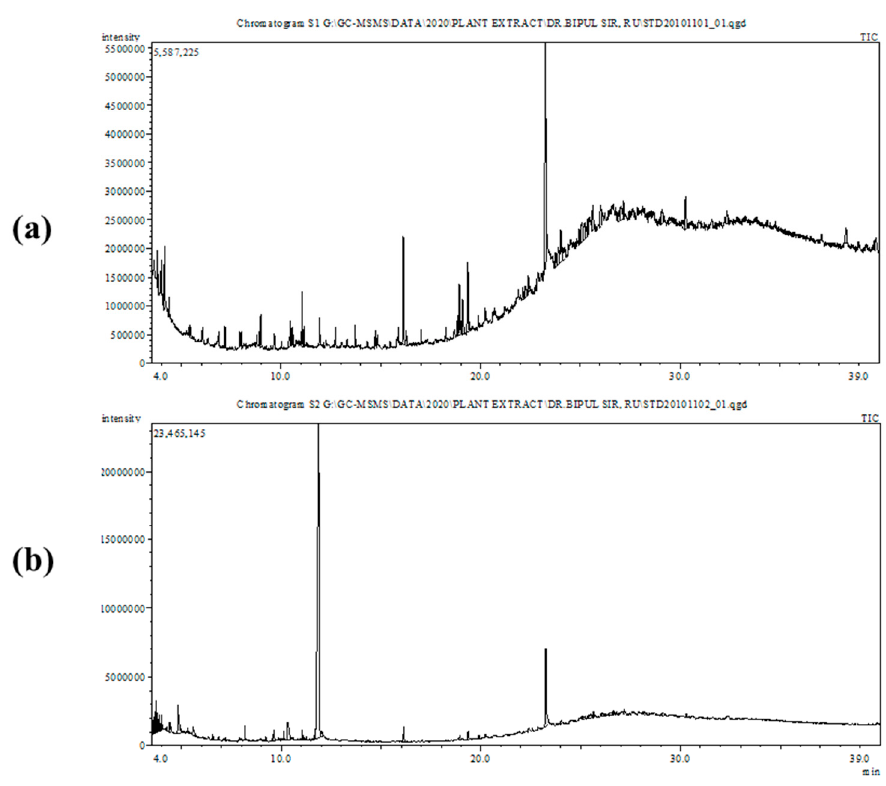
Figure 2. Total ionic chromatogram of A. officinalis methanolic extract of ( a ) leaves and ( b ) fruits by GC-MS.